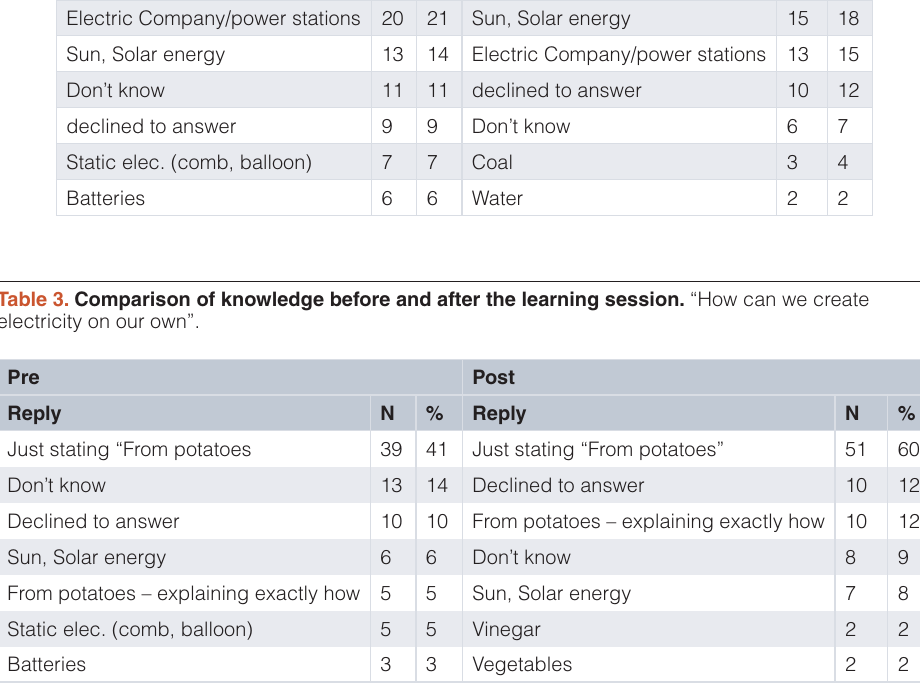
Static elec. (comb,